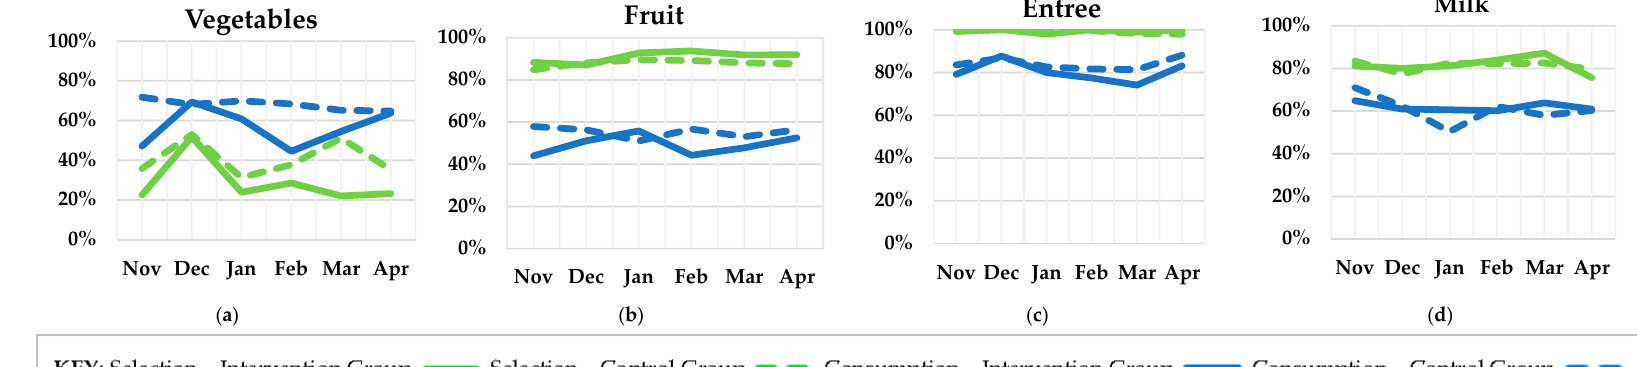
Figure 5. Selection (percent of students who selected food) and consumption (average percent of food consumed) outcomes at each of the six time points for the following food groups: ( a ) Vegetables (includes both hot vegetables and vegetables from the salad bar, ( b ) Fruit (includes both whole fruit and fruit from the salad bar), ( c ) Entrée, and ( d ) Milk. Sample size ranged from 85 to 112 for the intervention group and 145–187 for the control group across the six time points. Estimated marginal means are displayed for consumption variables while original frequencies are displayed for selection variables. Table 5. Influence of Condition (Intervention vs. Control Group) on Food Selection at Pre-Intervention, Post-Intervention, and Five Month Follow-Up.